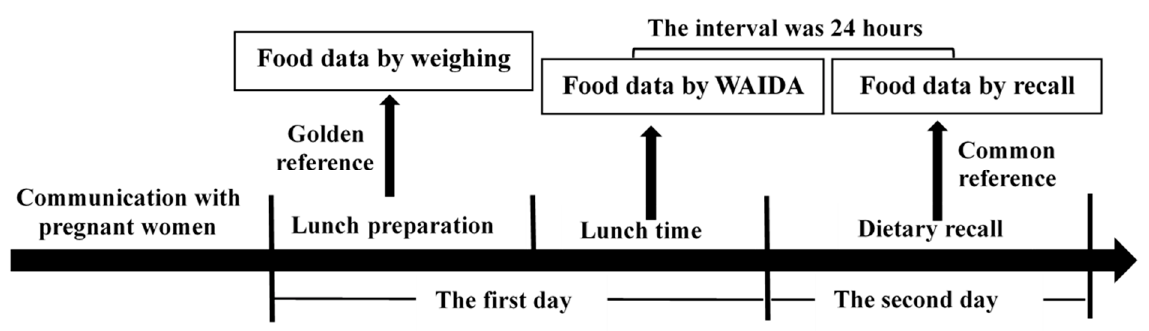
Figure 2. The design of the study investigating 251 pregnant women in Danyang, China.